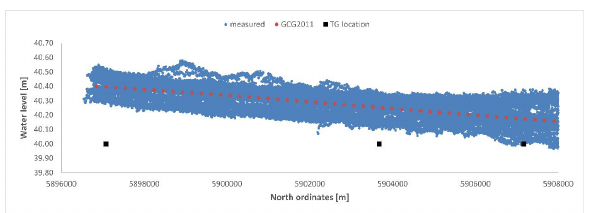
Figure 7: North-south cross section of the river segment under in- vestigation. Results obtained using all measured data points. Red dots representing the geoid heights obtained from the GCG2011 model. Black squares represents the tide gauge location along the river.